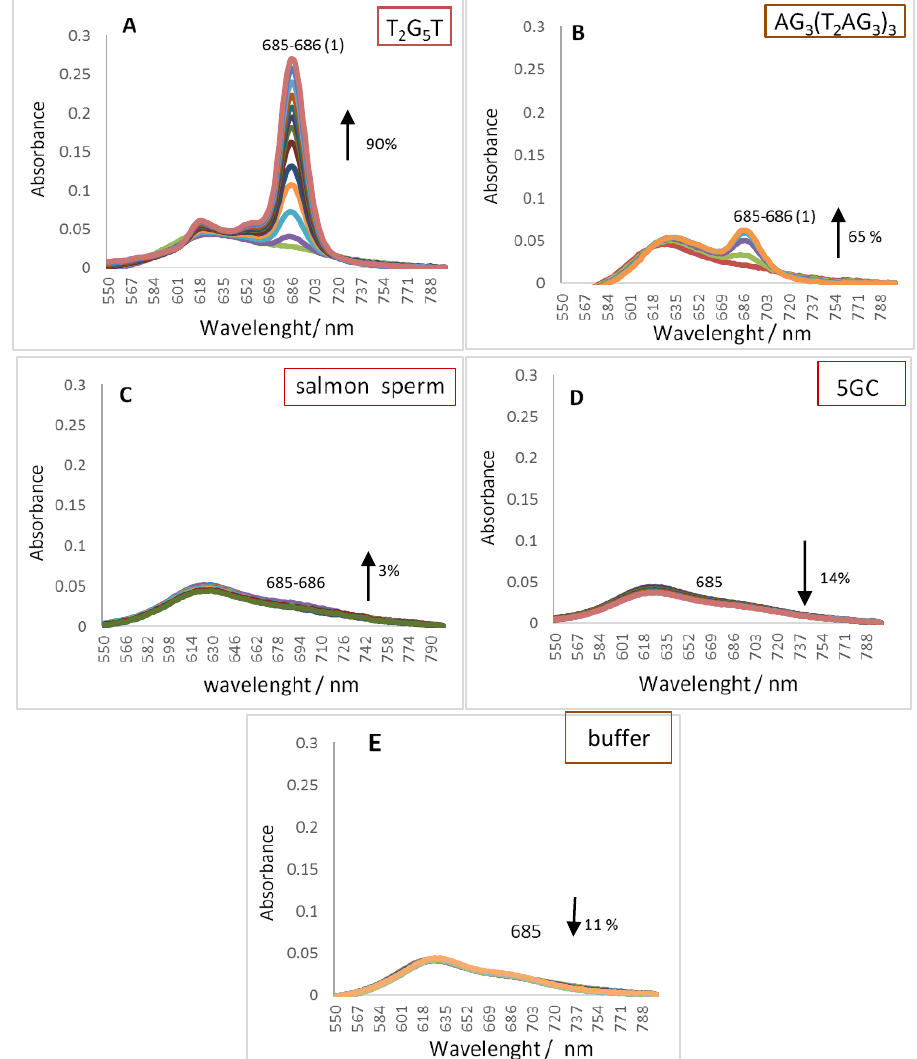
Figure 5. UV-Vis absorption spectra (550−800 nm) for the titrated solutions of ZnPc3 (2.0 μM) with ( A ) tetramolecular GQ, ( B ) unimolecular GQ, ( C ) salmon sperm, ( D ) 5GC, and ( E ) 20 mM PBS buffer with 100 mM KCl.